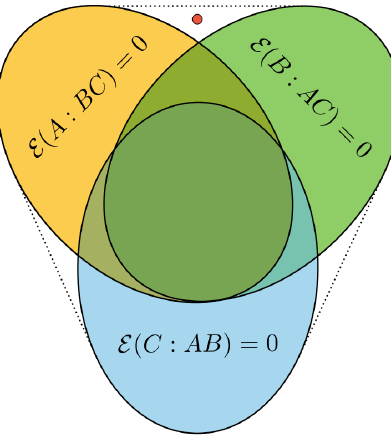
Figure 10: Different sets of separable combs. All states outside the convex hull of separable combs are GME. As we show in the main text, there are processes that are not bi-separable, but also not GME (the red dot in the figure would correspond to such a